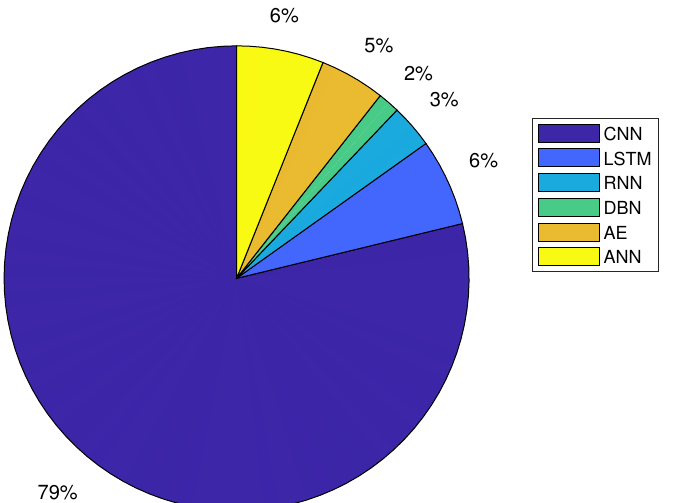
Figure 4. Visual illustration of the deep learning techniques applied to controlled environment agriculture in 2019–2022 (Focusing on the reviewed